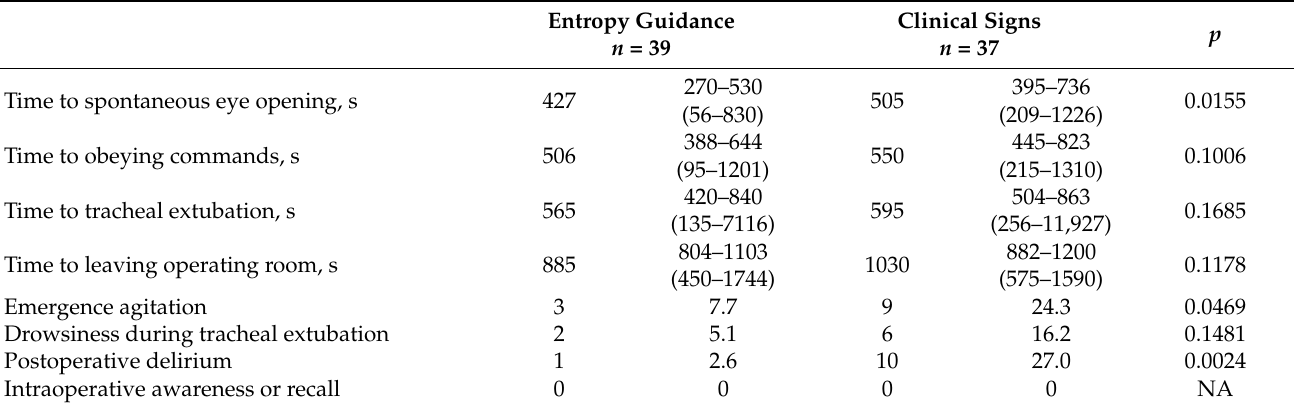
Table 4. Emergence from anesthesia and postoperative